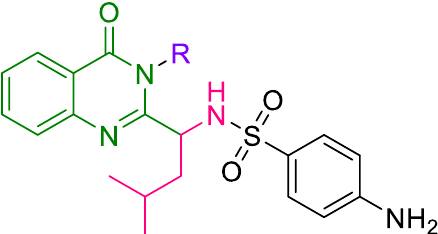
Figure 73. Leu linked sulphonamide-quinazolinone hybrid derivatives.